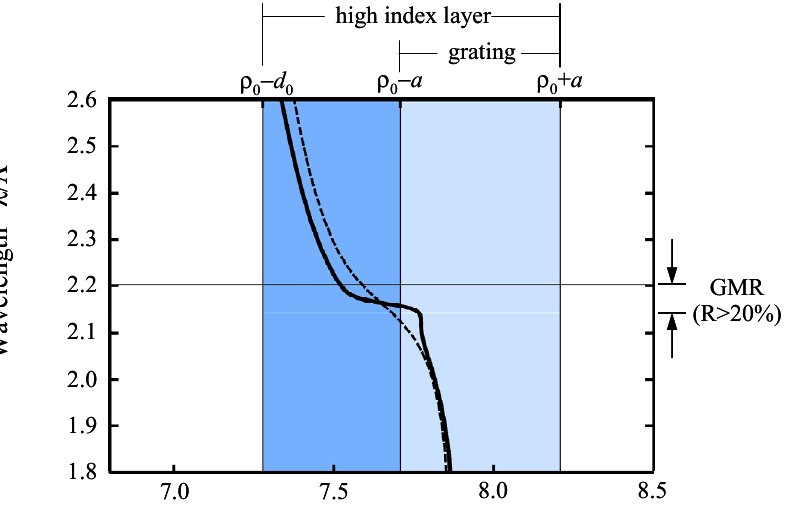
Figure 6. Estimated effective high-index mirror positions, for the m = 50 structure. Solid and dashed lines are curved RG and average index slab,